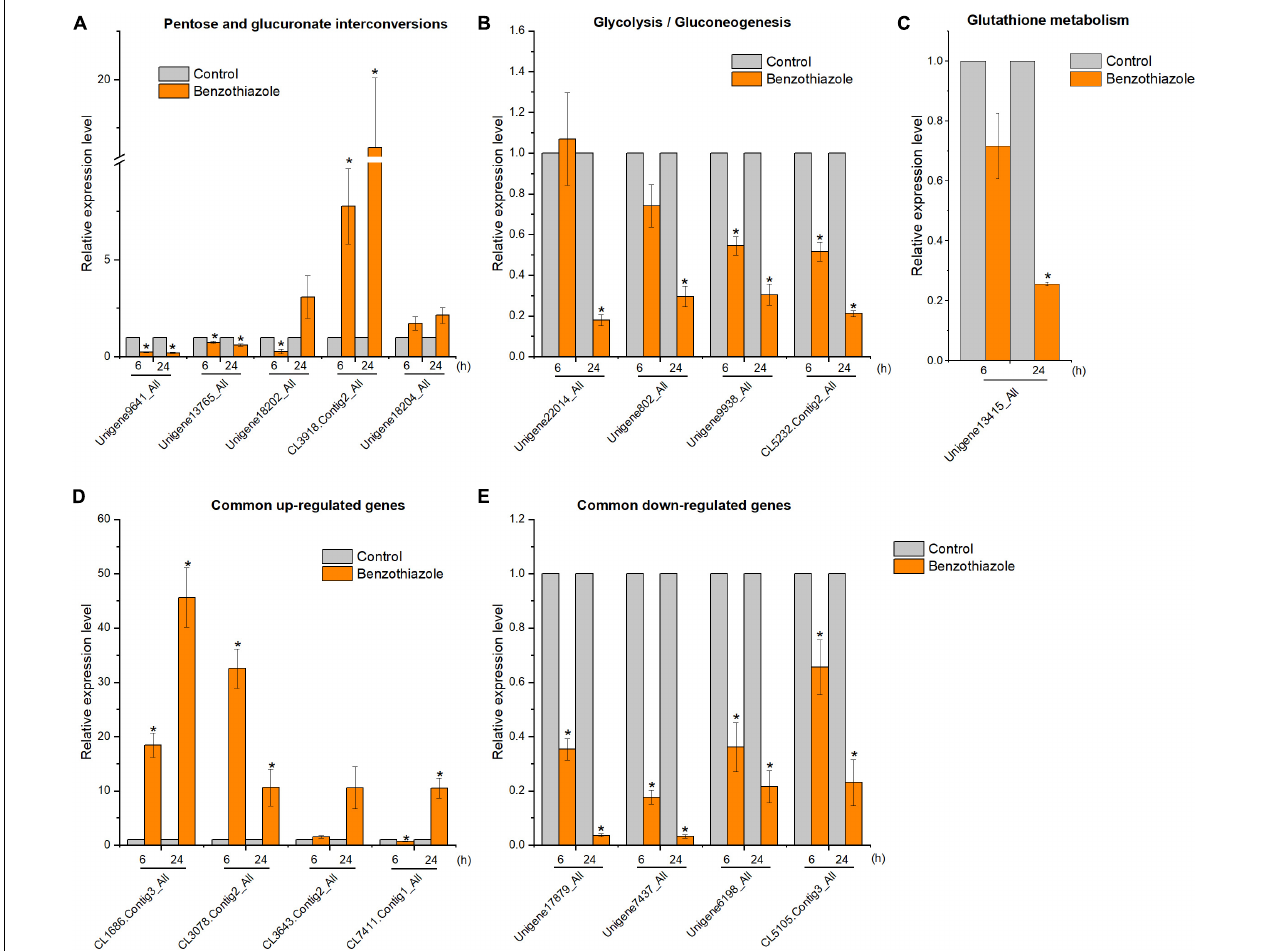
FIGURE 9 | Relative expression levels of selected DEGs in Bradysia odoriphaga by RT-qPCR. (A) Expression profiles of genes related to the pentose and glucuronate interconversions pathway. (B) Expression profiles of genes related to the glycolysis/gluconeogenesis pathway. (C) Expression profiles of genes related to the glutathione metabolism pathway. (D,E) Expression profiles of 4 common upregulated and 4 downregulated DEGs at 6 and 24 h. Ribosomal protein S15 (RPS15) was used as an internal control gene for normalization. The asterisk indicates a significant difference from the respective